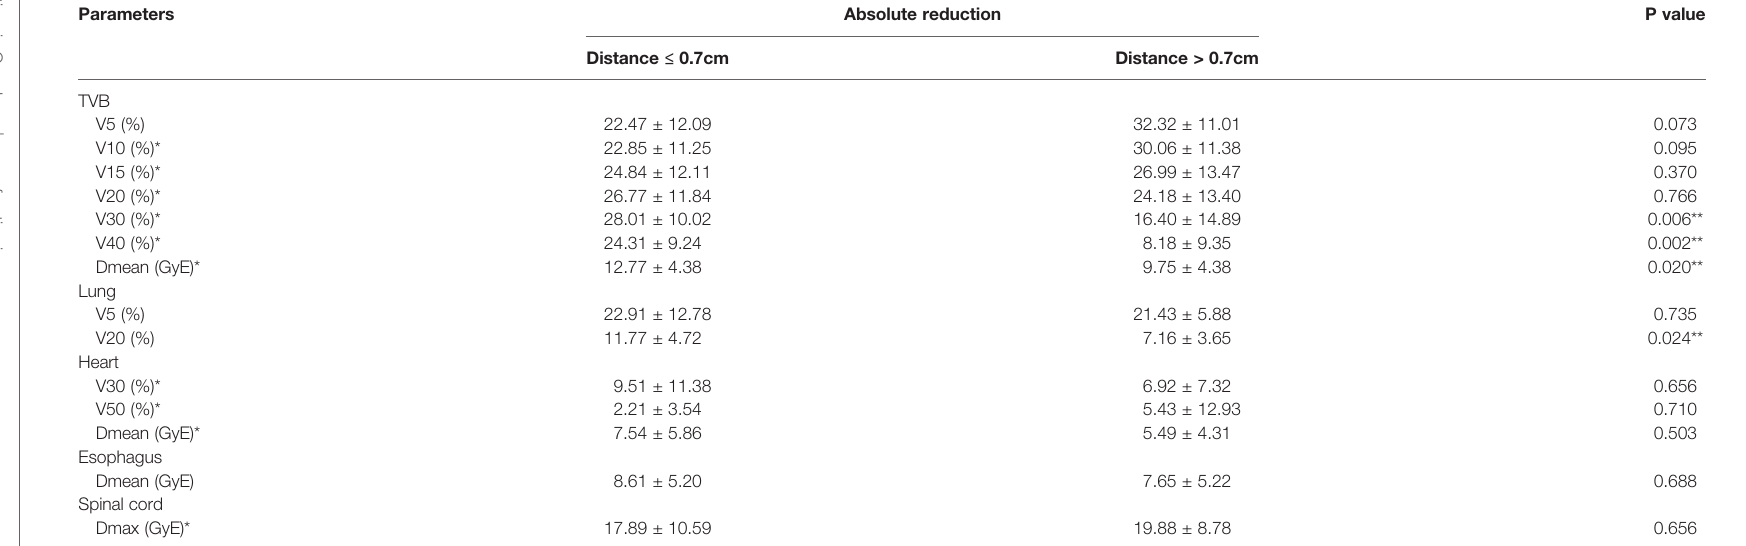
TABLE 3 | Comparison of absolute reduction on dosimetric parameters of organs at